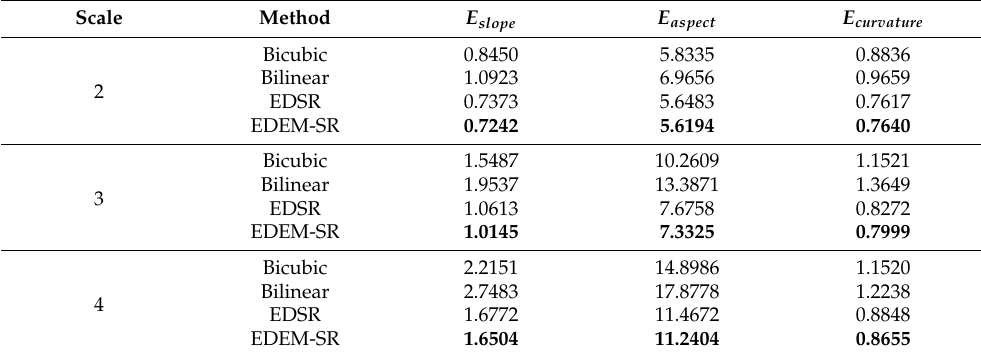
Table 3. Quantitative evaluation of terrain parameter